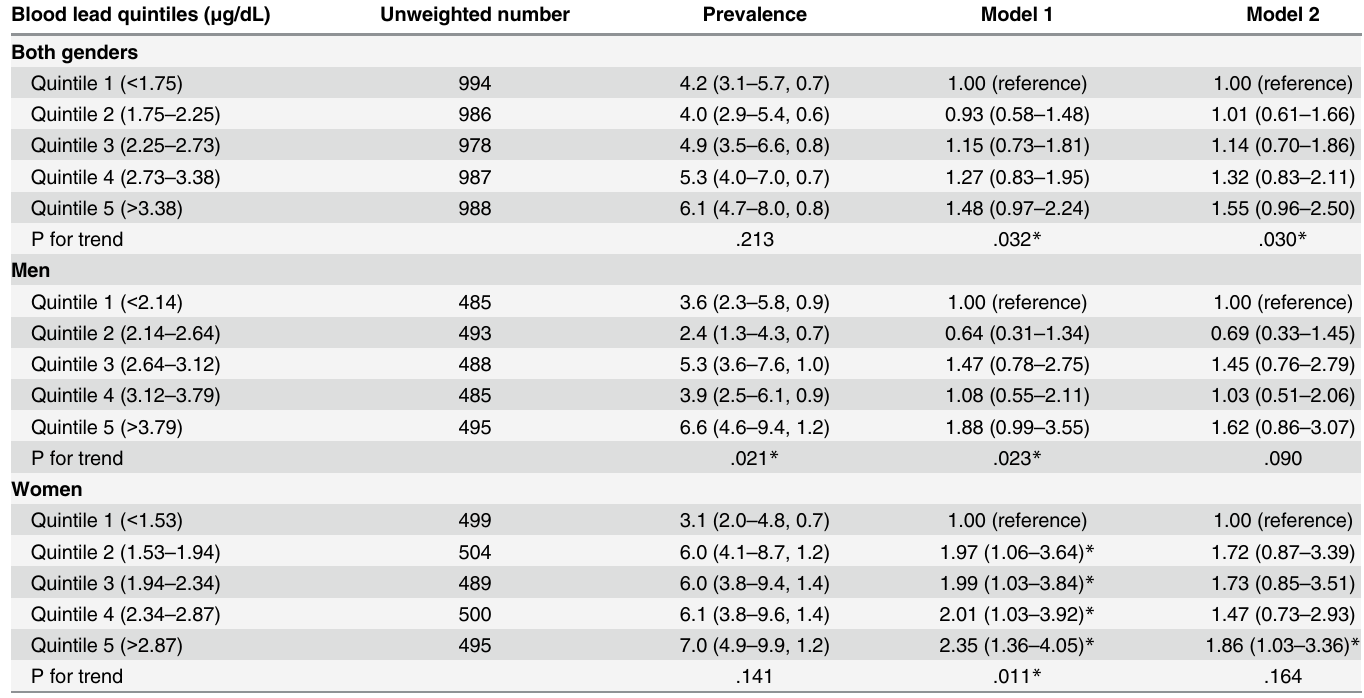
Table 3. Prevalence and adjusted odds ratio of any type of age-related macular degeneration (AMD), stratified according to quintile category of blood lead among representative Korean adults aged 40 years or older included in the study. Prevalence is expressed as weighted estimates [%] (95% confidence intervals, standard errors [%]).